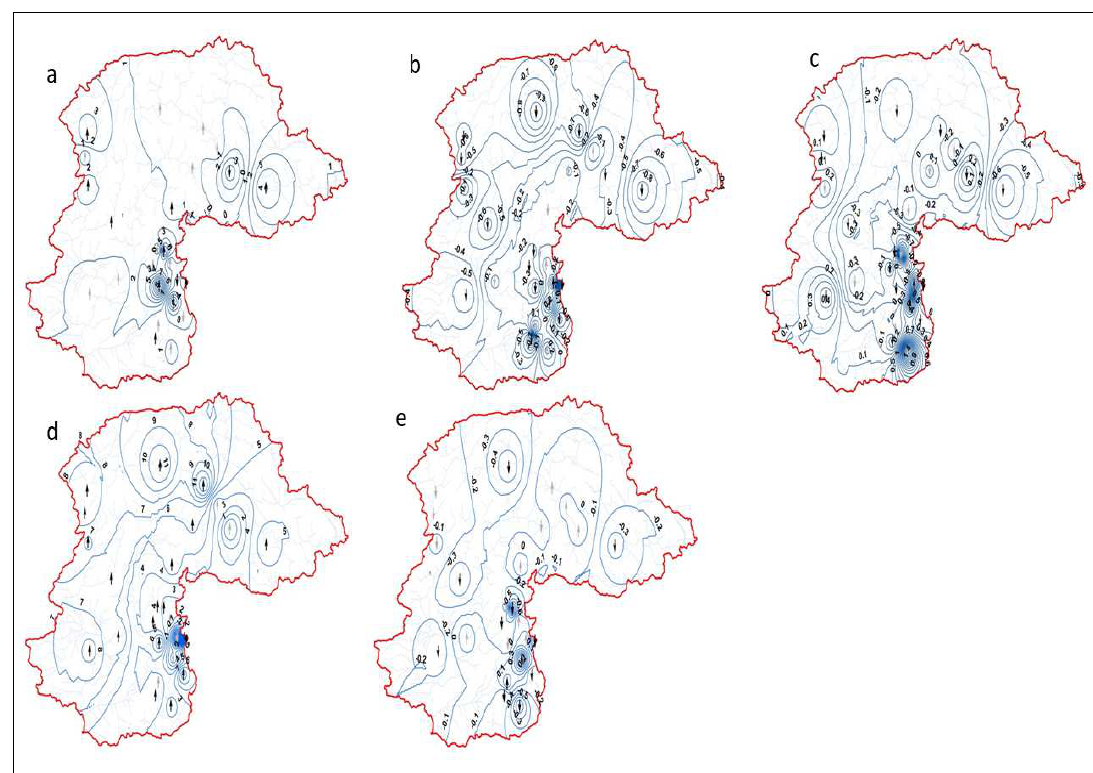
Figure 5. Spatial change in Tmin extreme indices: ( a ) FD0, ( b ) TNx, ( c ) TNn, ( d ) TR20, and ( e ) TNm.